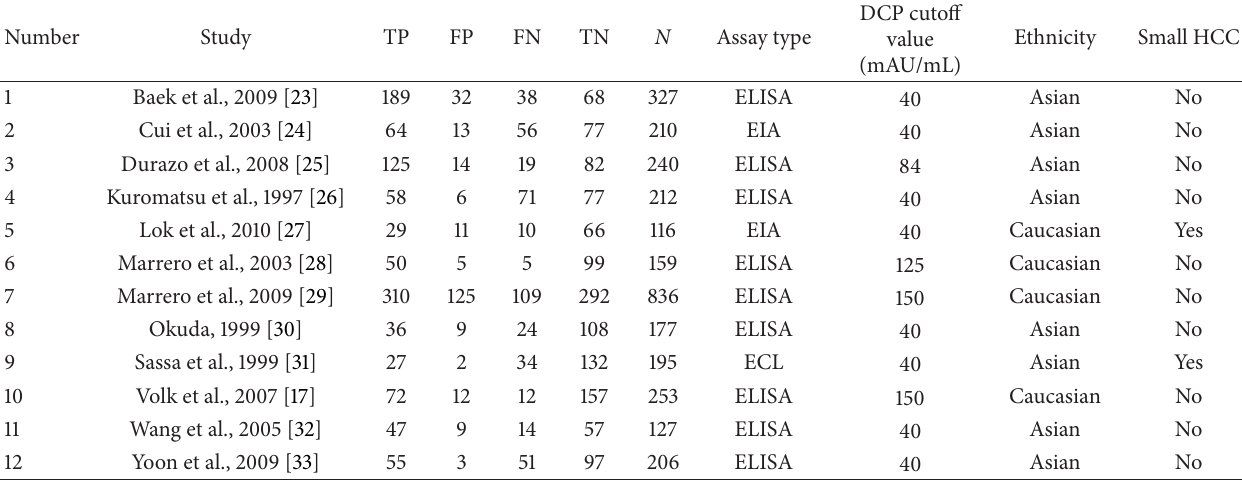
Table 1: Main characteristics of the studies included in the